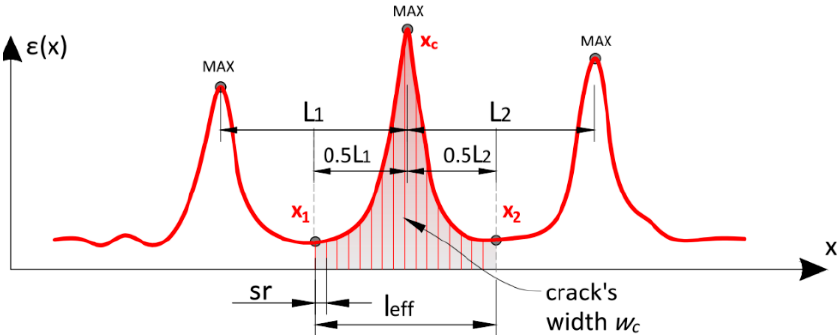
Figure 25. Scheme of calculation of the crack width using conservative approach.